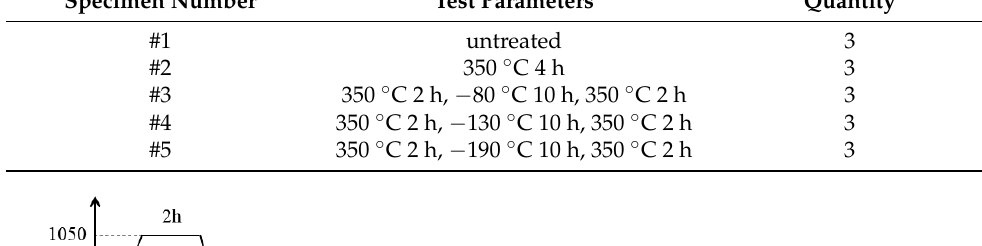
Table 2. Aging treatment parameters.